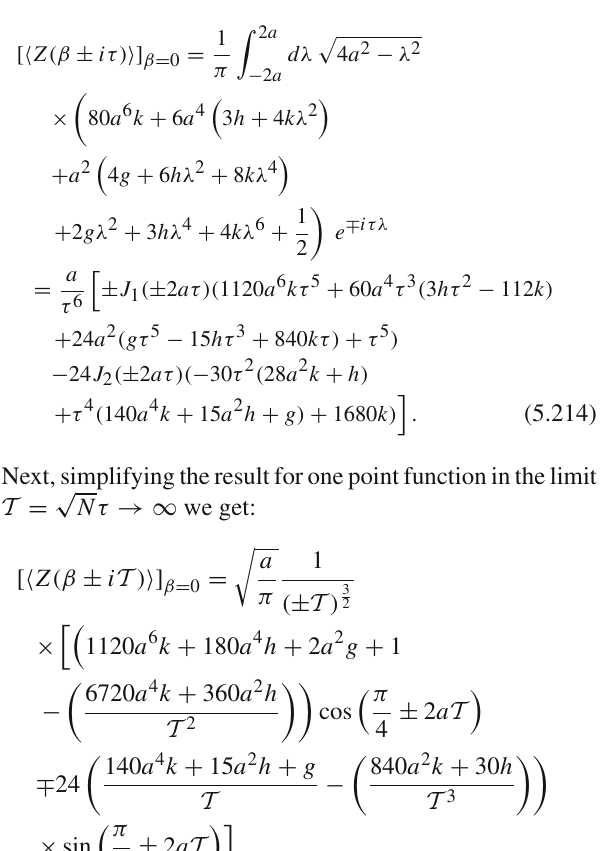
Further, considering the high temperature limiting